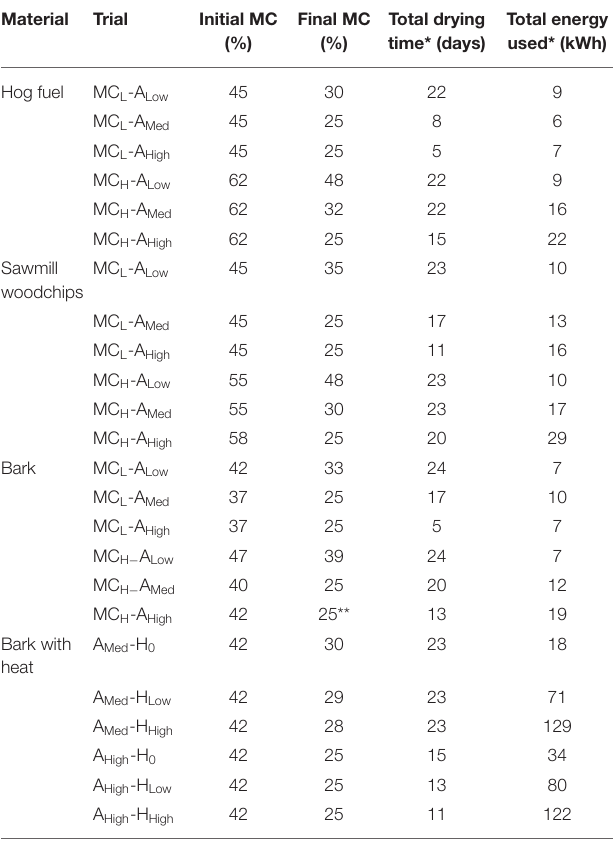
TABLE 6 | Total time and energy used to bring the material to an average of 25% MC or the energy used over the total drying period. Material